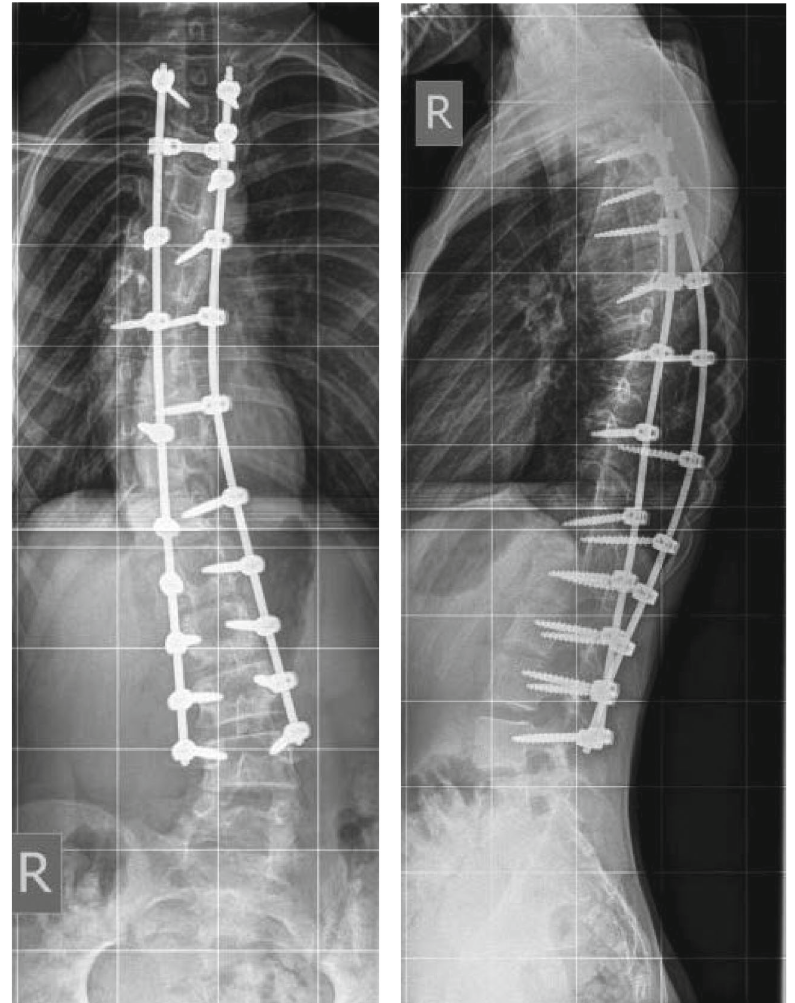
Figure 2: Anteroposterior and lateral X-rays demonstrating scoliosis correction with posterior